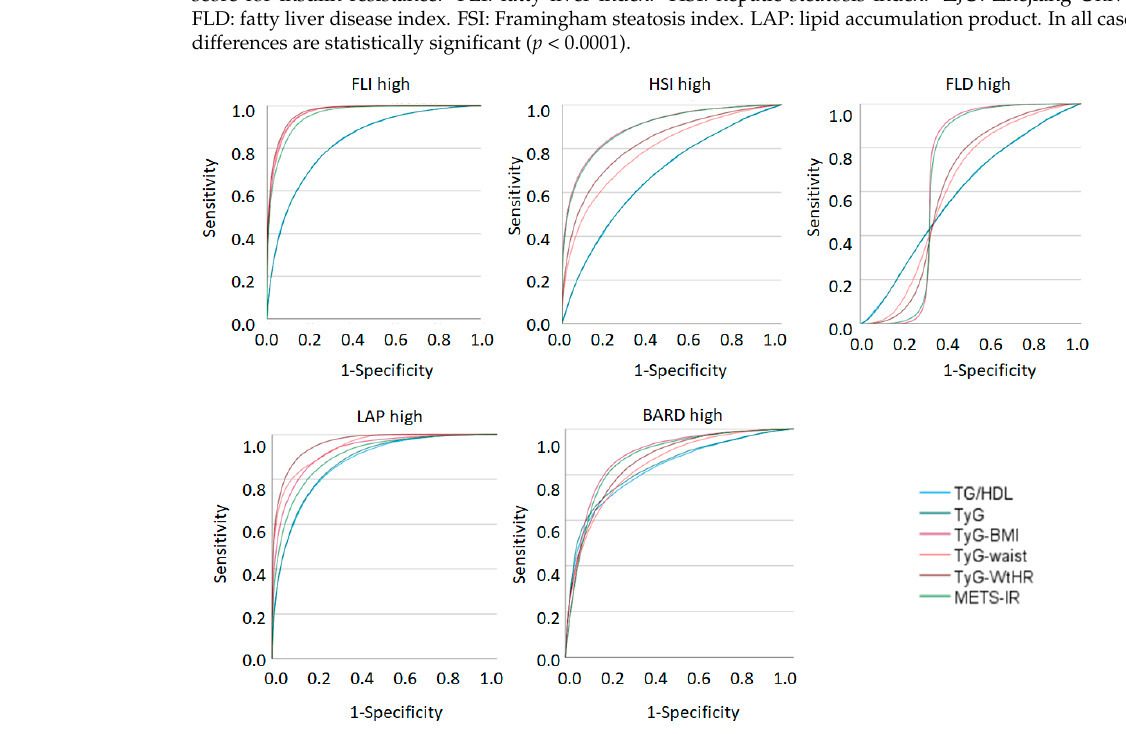
Figure 2. Areas under the curve of insulin resistance risk scales to predict the presence of high values of the NAFLD and liver fibrosis risk scales. TG: triglycerides. HDL-c: high-density lipoprotein cho-